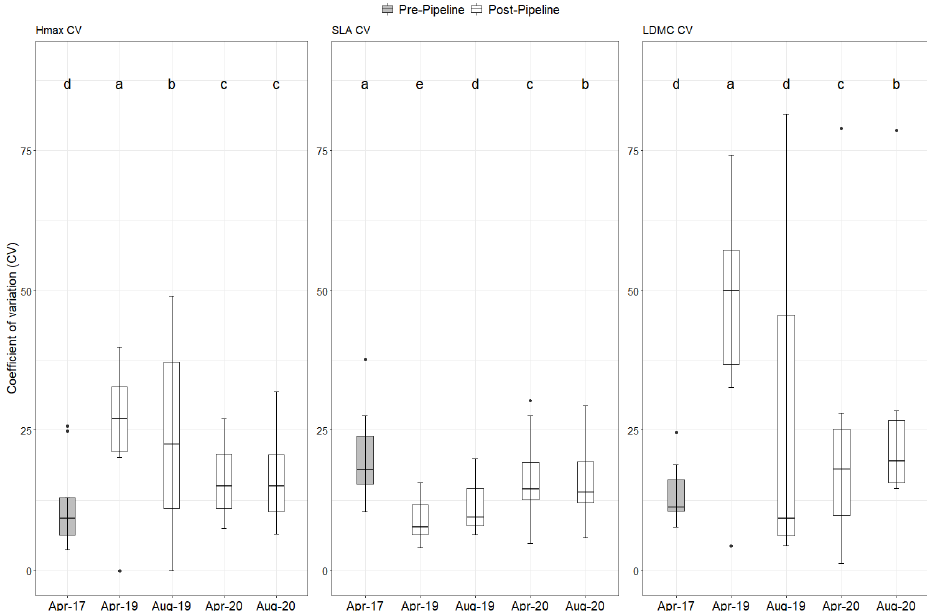
Figure 3. Coefficient of variation (cv) of the maximum plant height (H max ), specific leaf area (SLA), and leaf dry matter content (LDMC) at each of the five sampling events (before and after the project). Letters above the boxes indicate significant differences based on Tukey’s HSD at the p < 0.05 threshold.